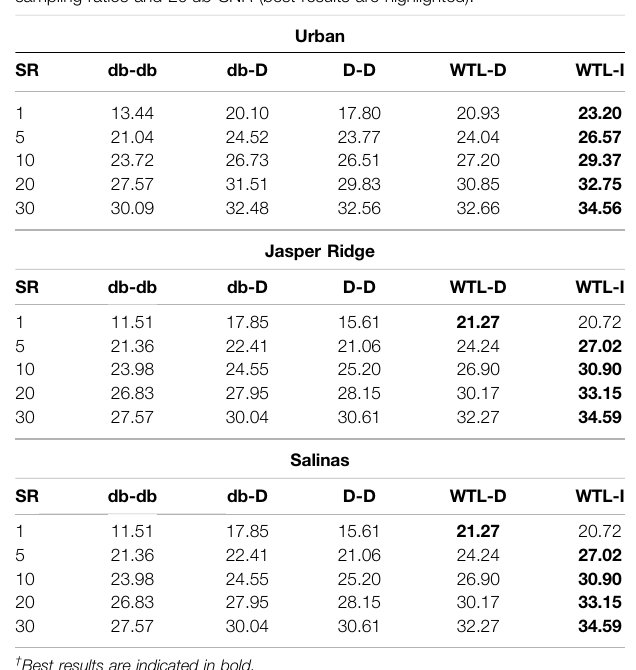
TABLE 1 | PSNR of reconstructed HSI with different sparsifying basis at different sampling ratios and 20 db SNR (best results are highlighted).